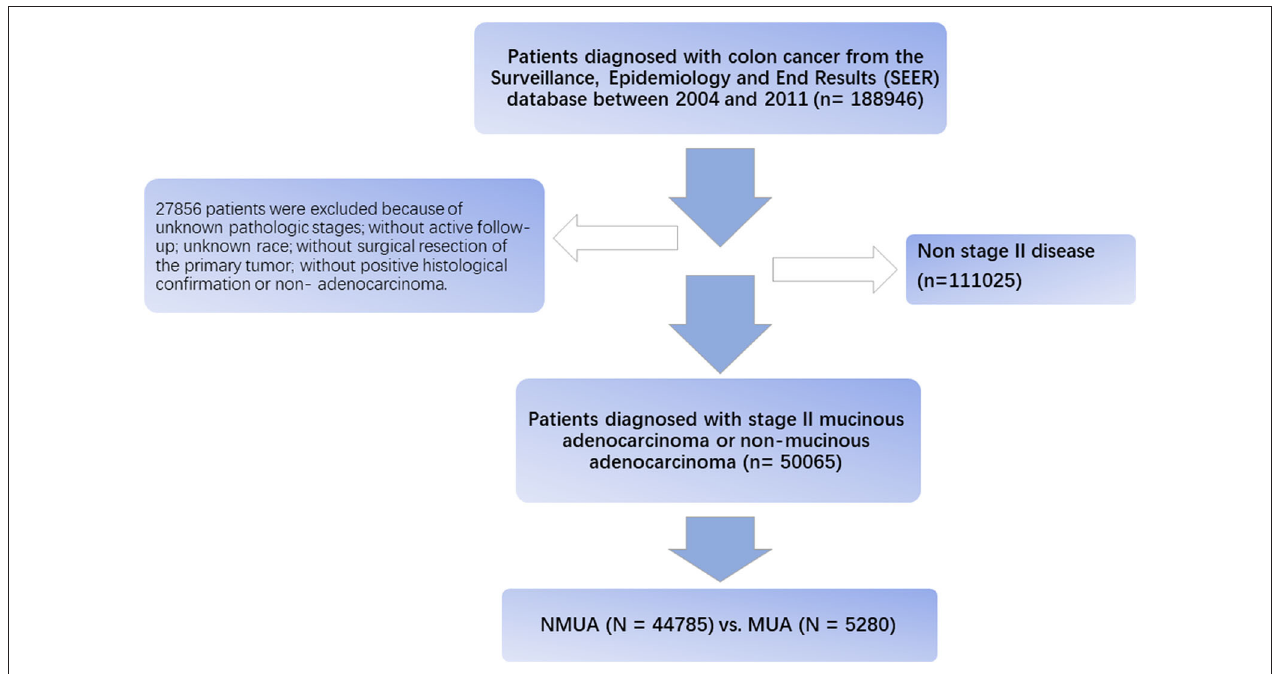
FIGURE 1 | Flowchart of patients’ cohort